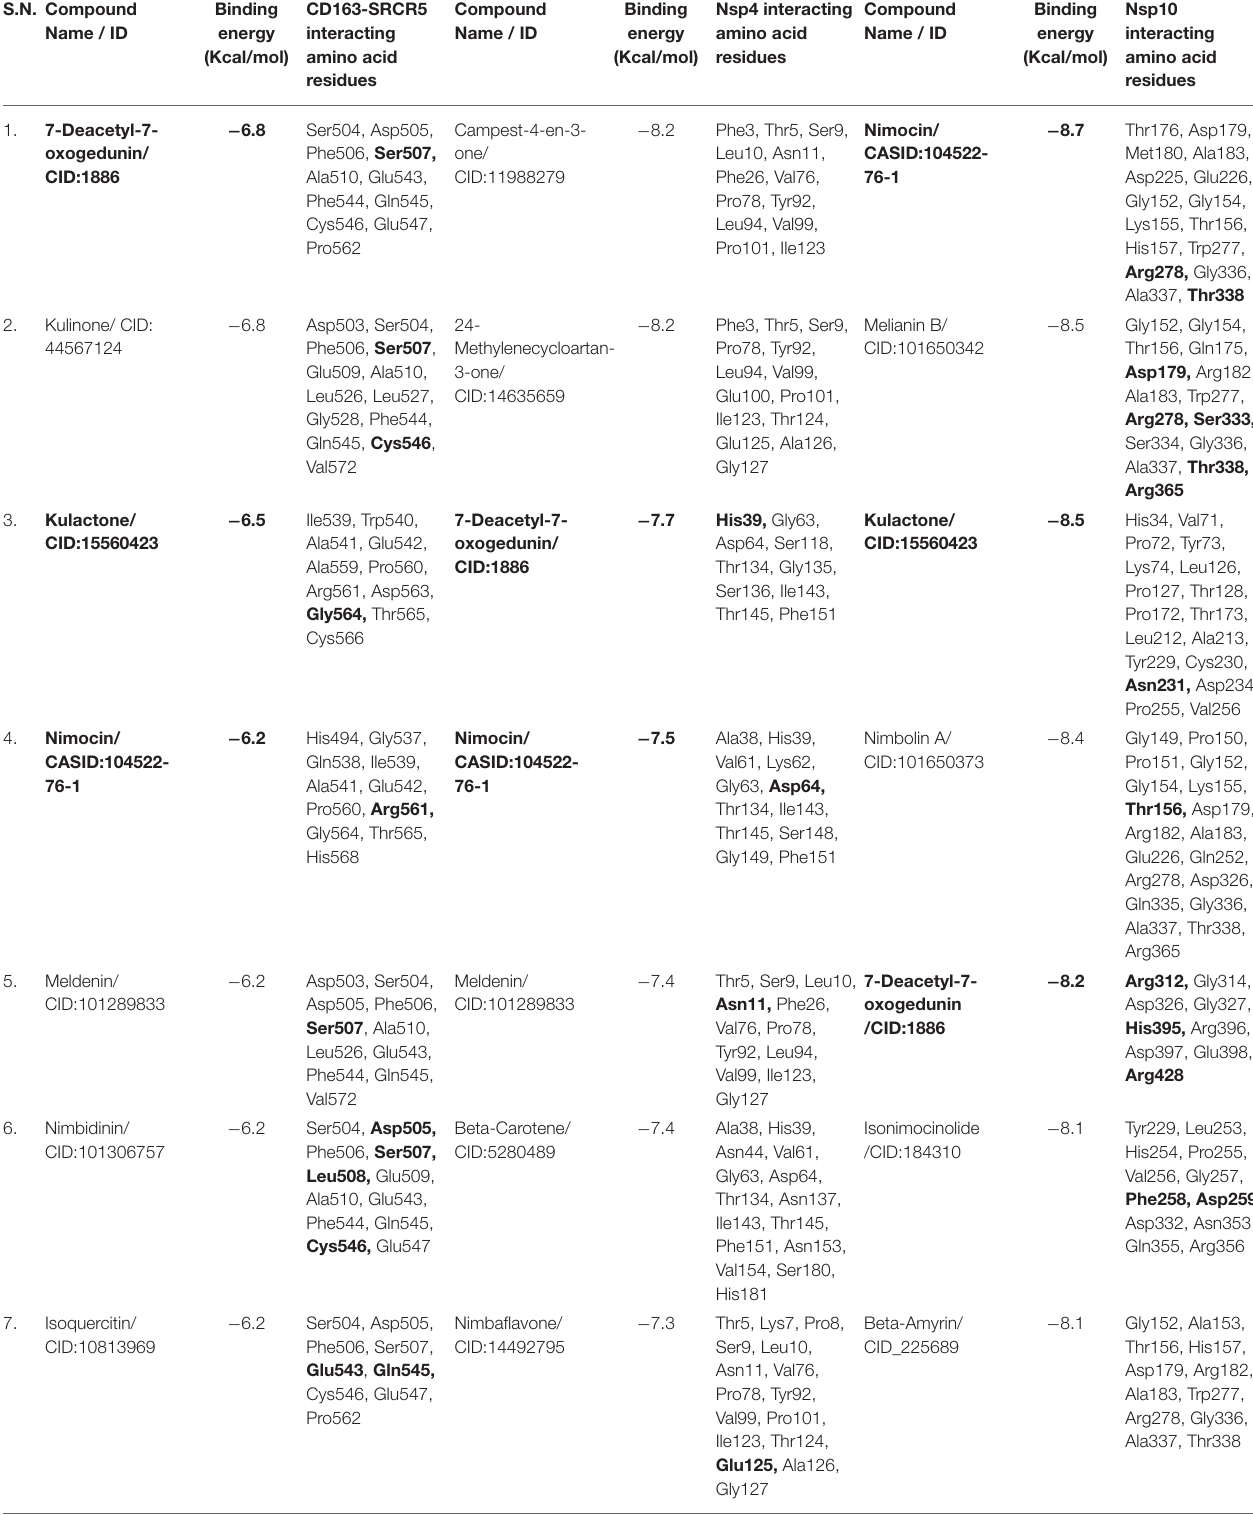
TABLE 1 | List of the top ten screened neem phytochemicals, their binding free energies, and interacting amino acid residues of target proteins [porcine CD163 scavenger receptor cysteine-rich domain 5 (CD163-SRCR5), and porcine reproductive and respiratory syndrome virus (PRRSV) non-structural protein 4 (Nsp4) and Nsp10 of